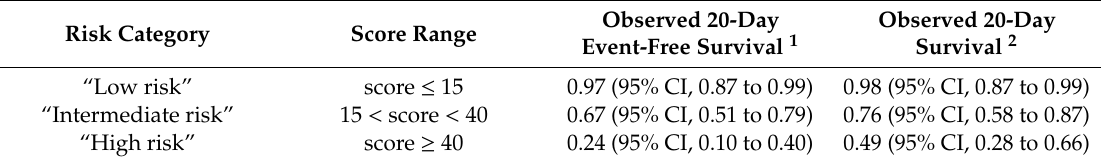
Table 3. Risk stratification: observed risk of “intensive care unit (ICU) transfer or death” and survival for each